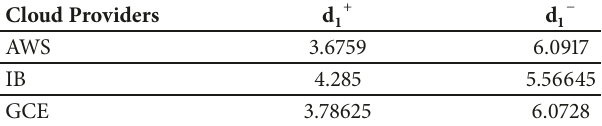
Table 4: Separation